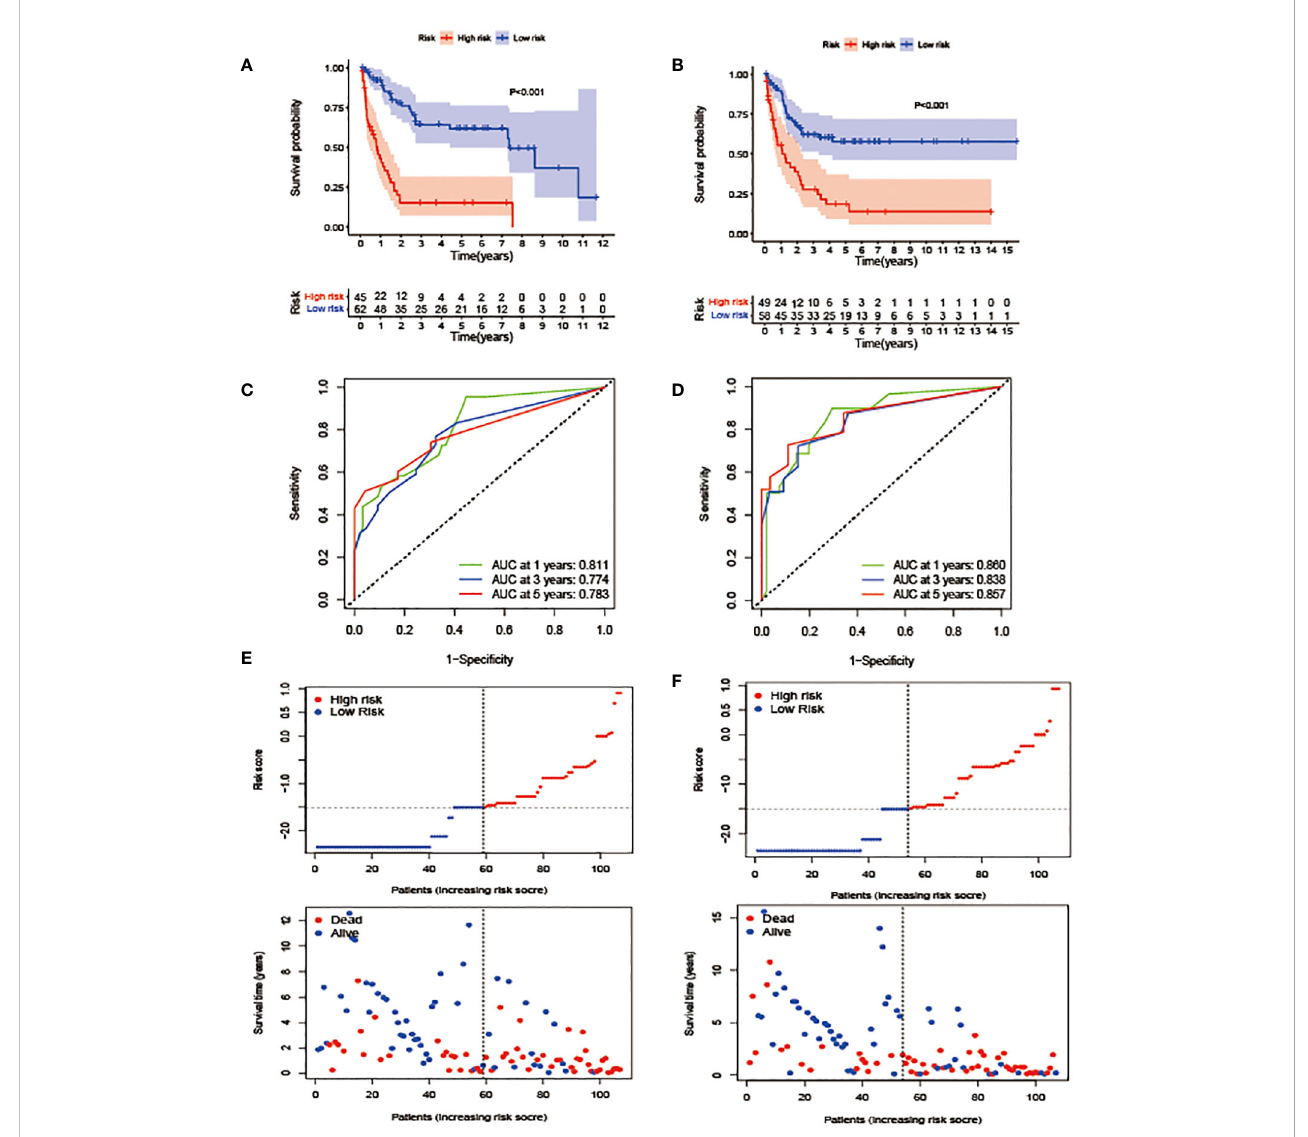
FIGURE 3 Construction and validation of the prognostic model. (A, B) . OS strati fi ed by the new lipid pro fi le risk score in the training (A) and validation (B) cohorts. (C, D) Areas under the curve (AUCs) of a receiver-operator characteristic (ROC) curve were compared among the one-, three-, and fi ve-year OS of the prognostic model in the training (C) and validation (D) cohorts. Higher AUC values indicate greater prediction accuracy. (E, F) Risk score analysis of the signature in the high- and low-risk groups in the training and validation